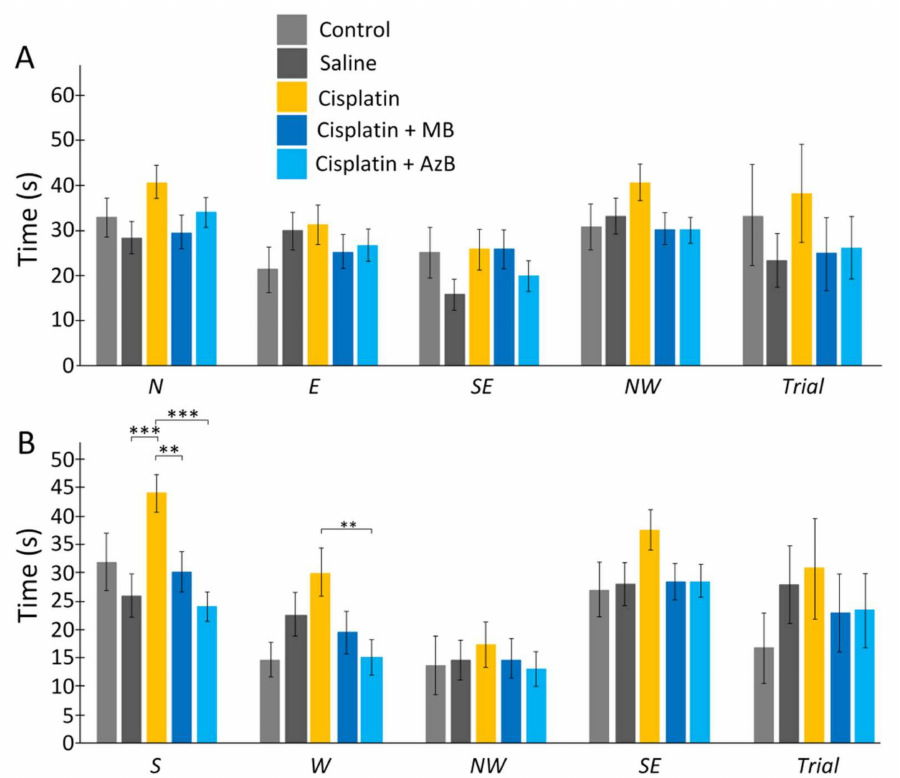
Figure 3. The Morris water maze. Time in the ( A ) acquisition, ( B ) reversal learning. The results ex- pressed as means ± SEM. Control n = 4, Saline = 7, Cisplatin= 6, Cisplatin+ MB = 8, Cisplatin+ AzB = 8. ** p < 0.01, *** p < 0.001, groups were compared using the U test.